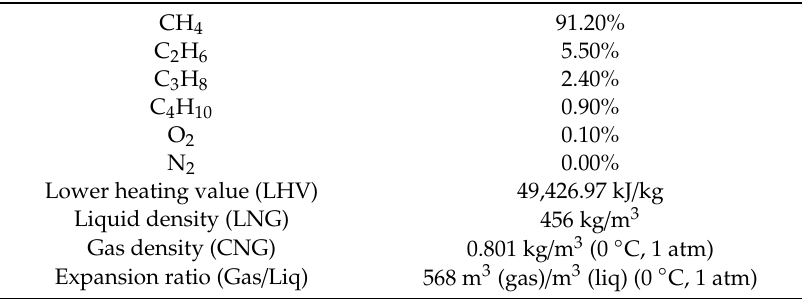
Table 4. The composition and characteristics of natural gas